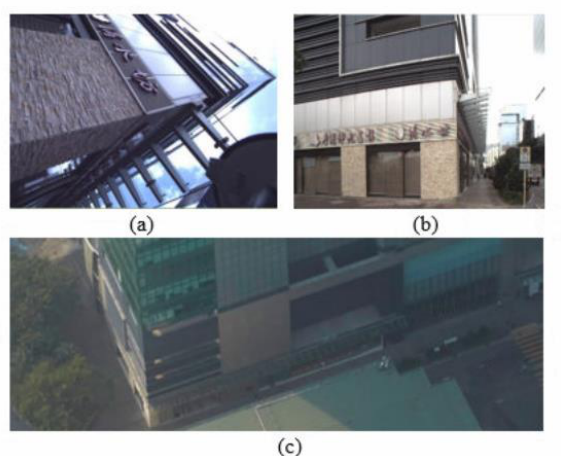
Figure 5. Representative images of the test area in Kowloon Bay, Hong Kong. (a) Backpack image, (b) MMS image, and (c) UAV image.